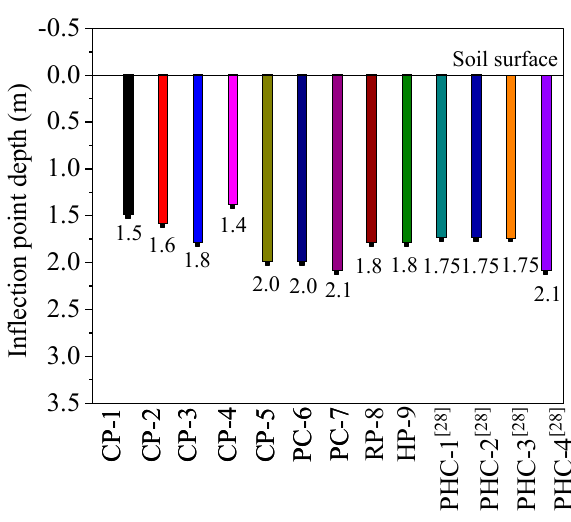
Figure 10. Inflection point depth of the specimens.